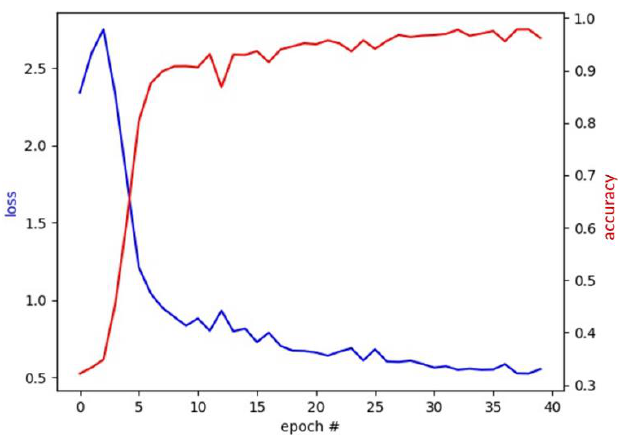
Figure 12. Validation loss and accuracy of the prediction with the highest test accuracy. Validation accuracy gets close to 1, no signs of overfitting.